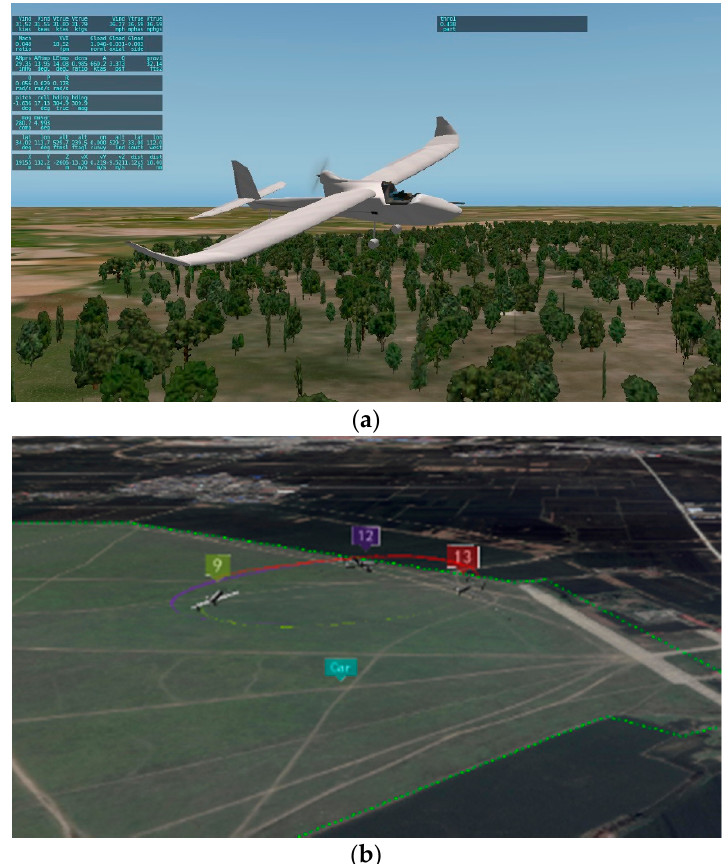
Figure 18. The snapshots of the target standoff experiments in HIL simulation in different perspectives. ( a ) HILStar 17F used in the X-plane simulator, ( b ) The tracking trajectory of the UAV around the car.